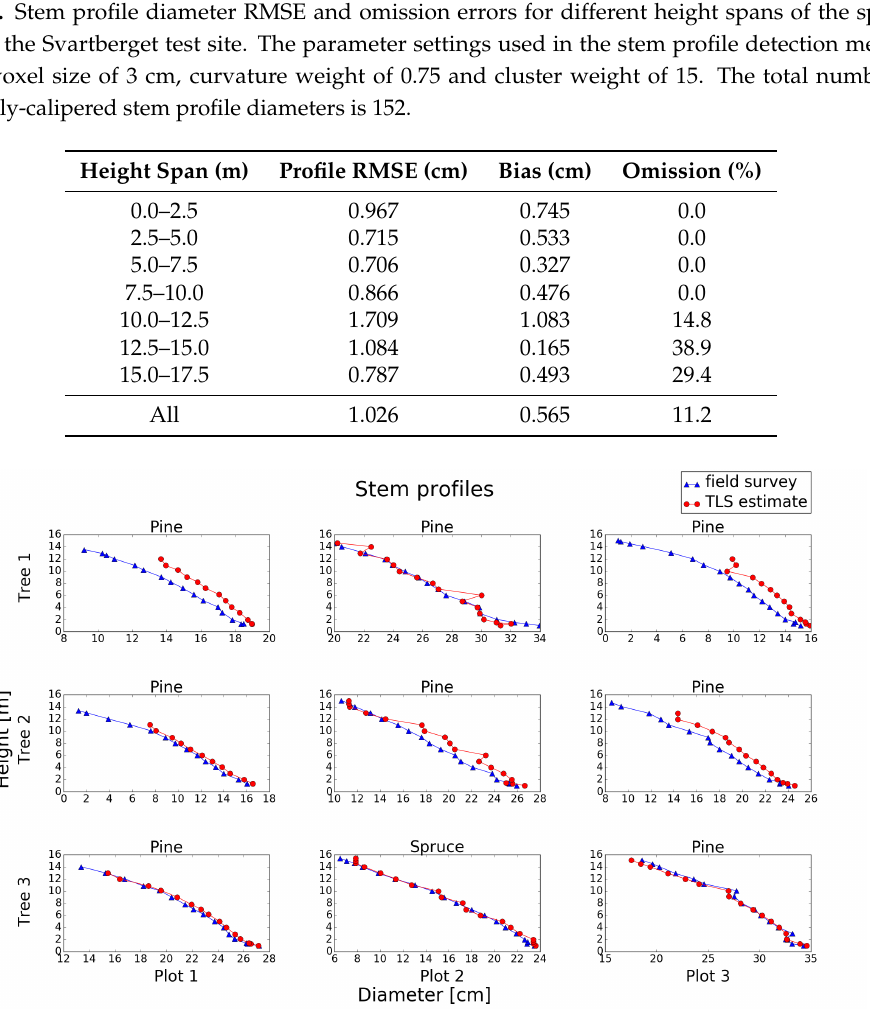
Figure 14. Stem profiles of the trees in Plots 1–3. The parameter settings used in the stem profile detection method were: voxel size of 3 cm, curvature weight of 0.75 and cluster weight of